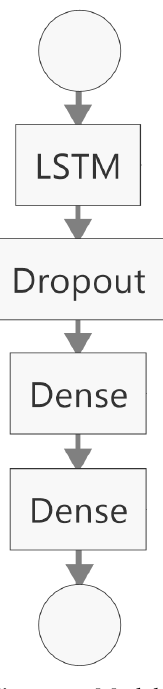
Figure 10. Model with one LSTM-layer.